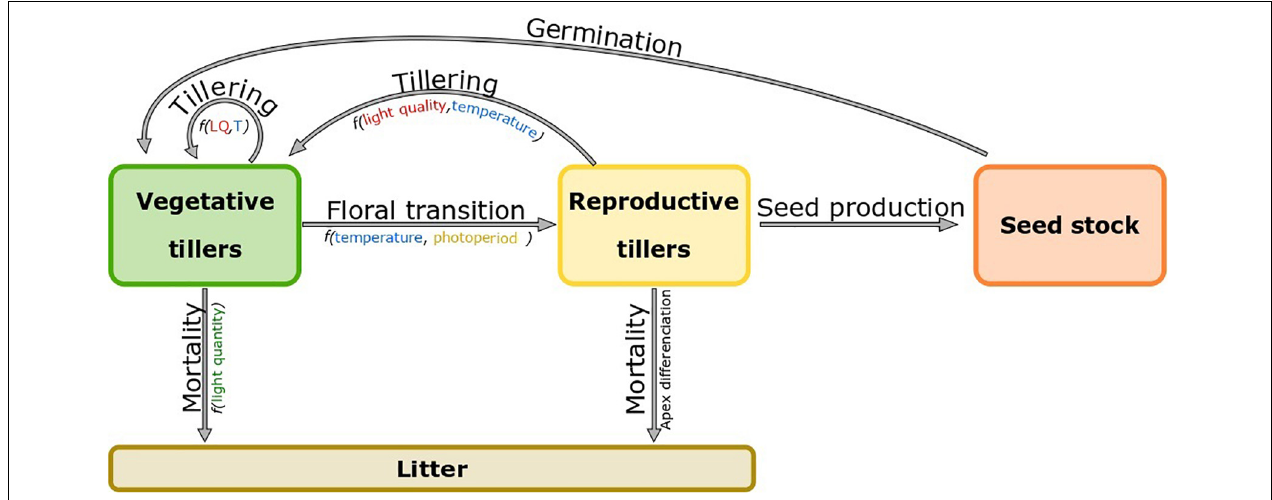
FIGURE 4 | Compartmental model of a perennial grass plant. The plant is divided into three compartments: vegetative tillers (green), reproductive tillers (yellow) and dead tillers composing a litter